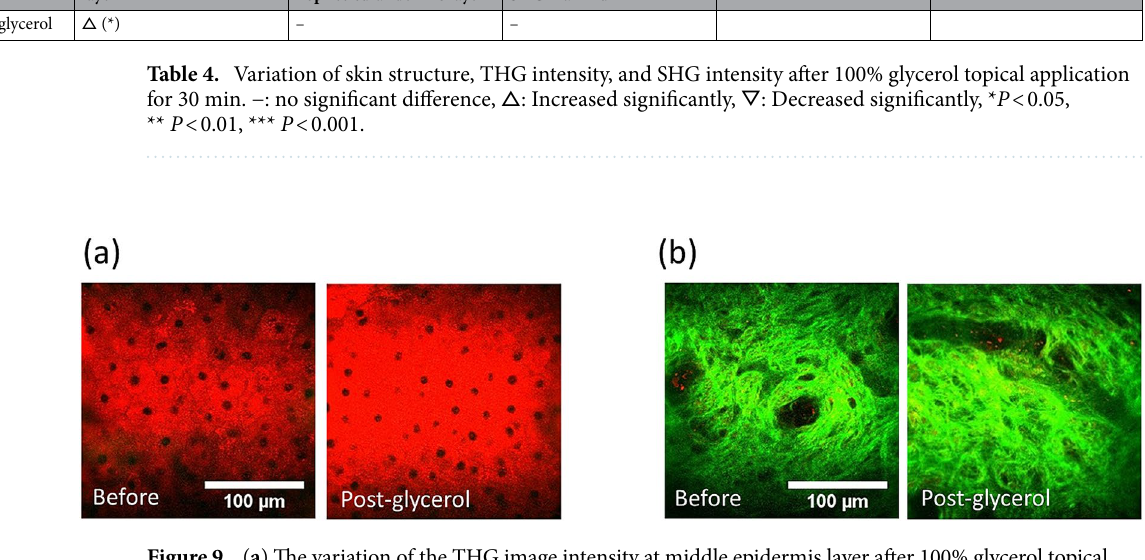
Figure 9. ( a ) The variation of the THG image intensity at middle epidermis layer after 100% glycerol topical application for 30 min. ( b ) The variation of the SHG image intensity at top reticular dermis layer after 100% glycerol topical application for 30 min. Before: before treatment; Post-glycerol: after treatment. Scale bar = 100